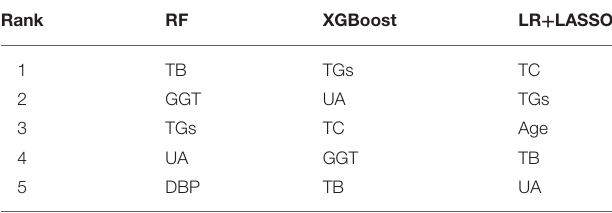
TABLE 5 | Ranks of feature importance in RF, XGBoost, and LR + LASSO for predicting AF.